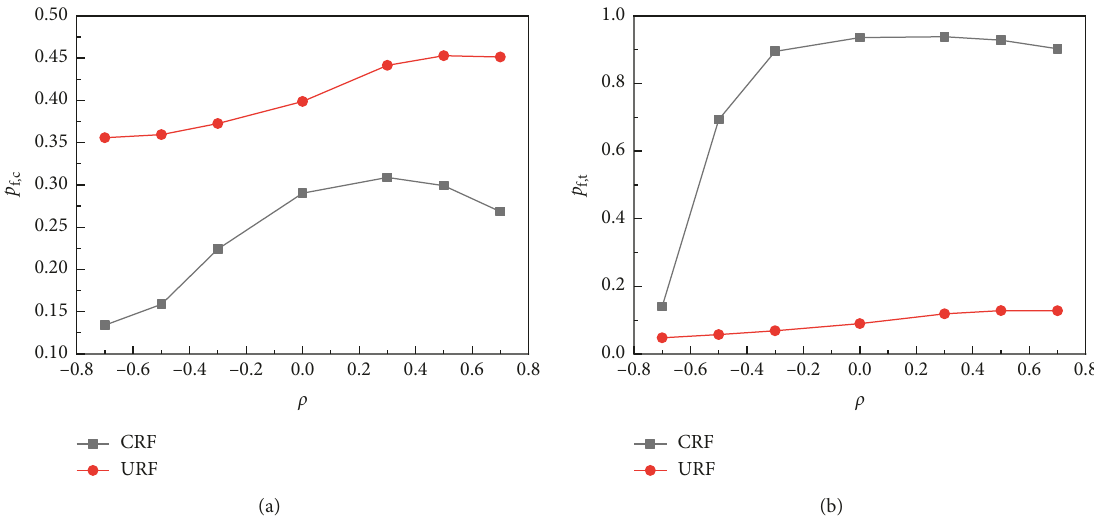
Figure 9: Effect of the cross-correlation coefficient on the probability of failure of tunnel liner under both unconditional and conditional random fields: (a) compression failure and (b) tension failure.